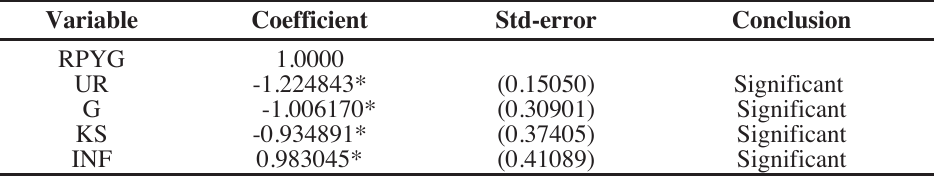
Results of Normalized co-integrating